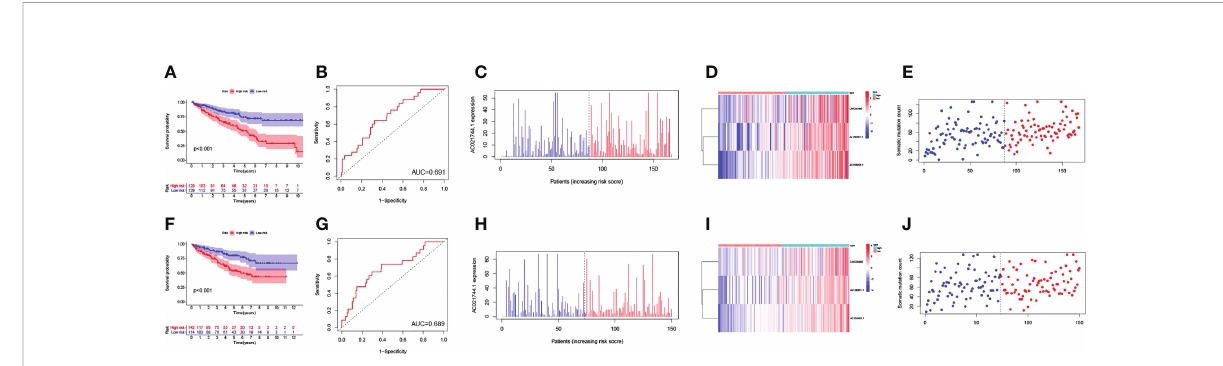
FIGURE 4 Validation of the GILncSig model. (A) The survival analysis in training set; (B) The ROC curve in training set; (C) The expplot analysis in training set; (D) The heatmap in training set; (E) The mutplot analysis in training set; (F) The survival analysis in testing set; (G) The ROC curve in testing set; (H) The expplot analysis in testing set; (I) The heatmap in testing set; (J) The mutplot analysis in testing set.